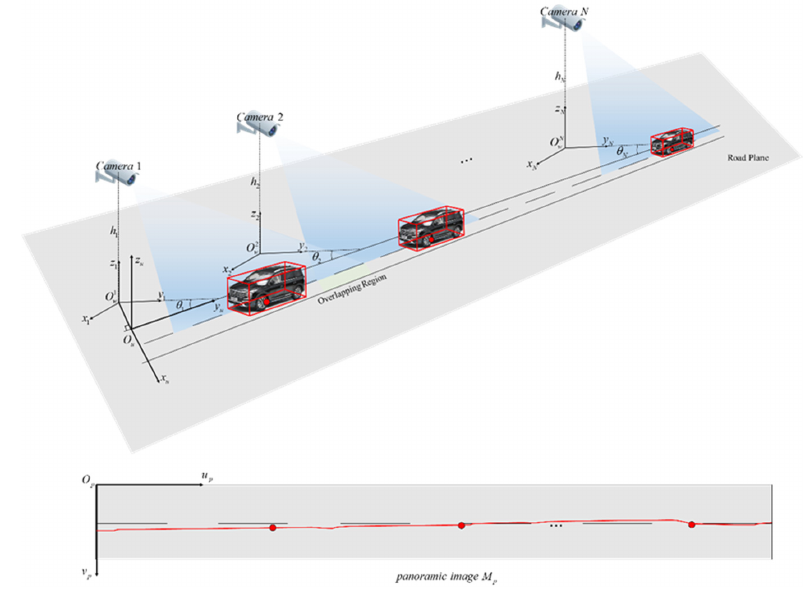
Figure 9. Schematic diagram of vehicle spatial distribution and 3D trajectory extraction in cross- Figure9. camera scenes.